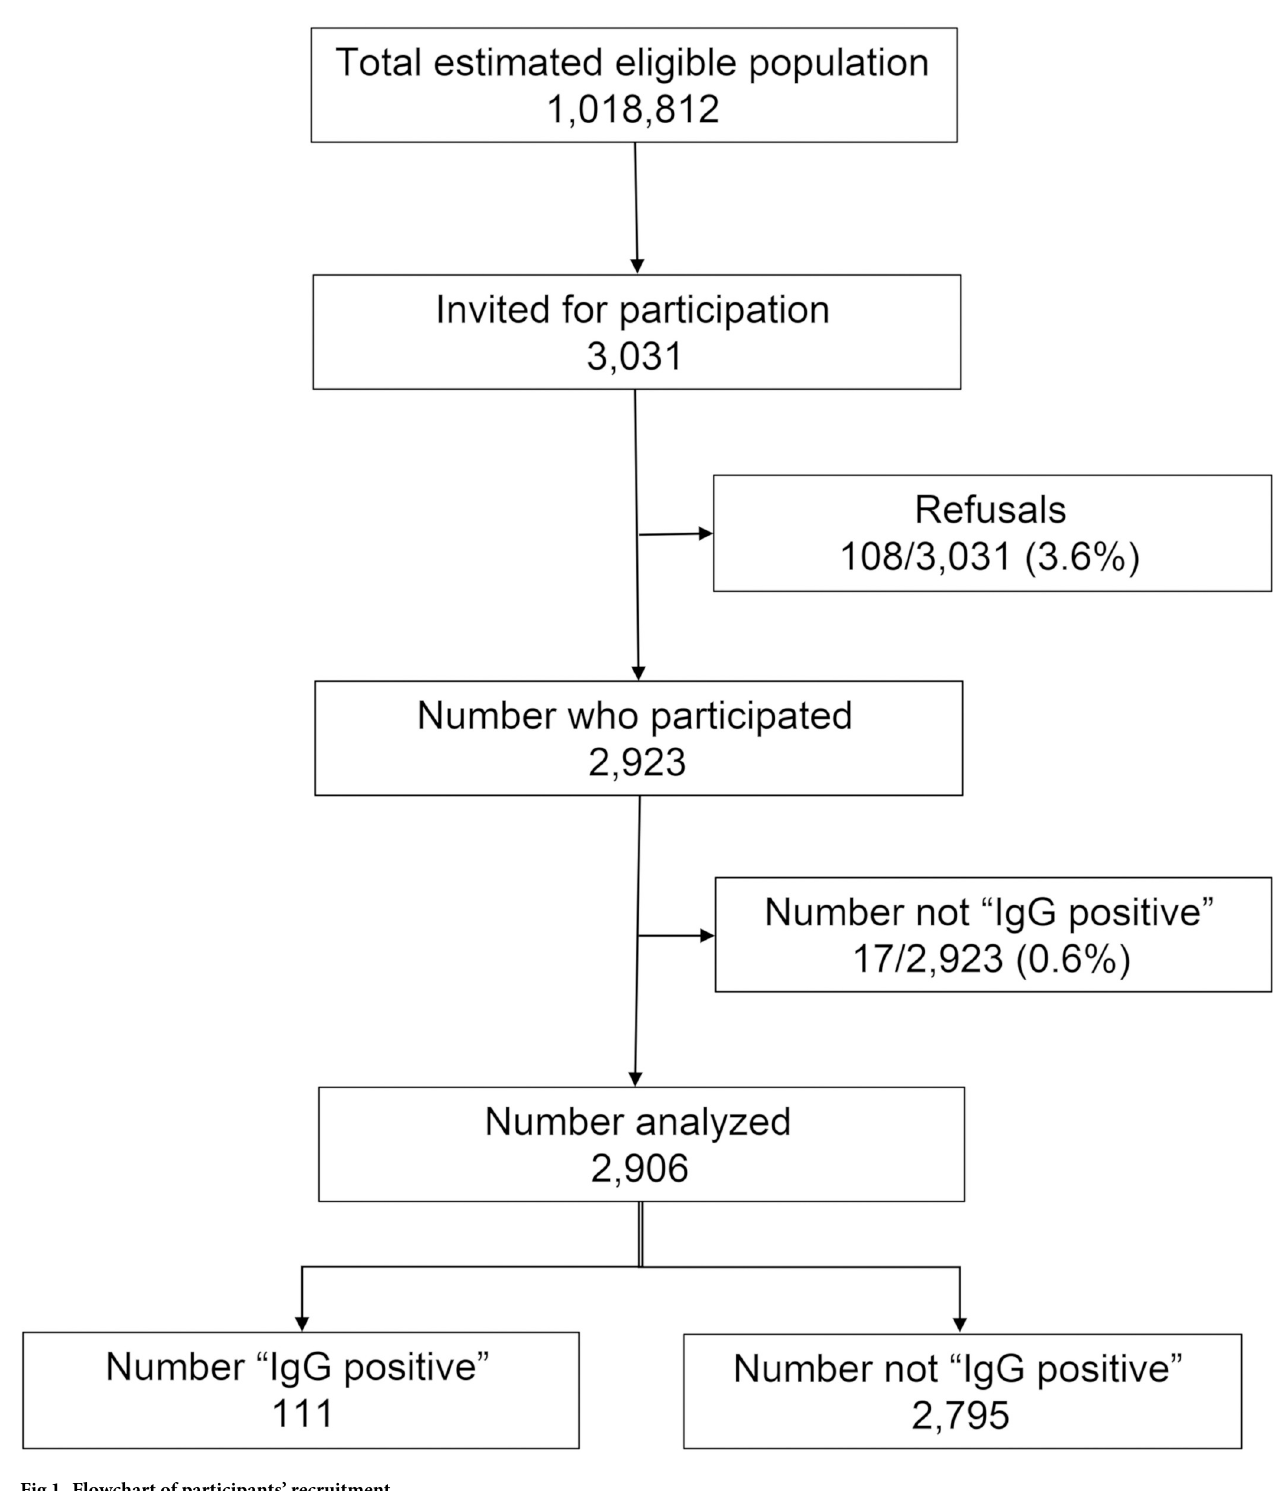
Fig 1. Flowchart of participants’ recruitment.